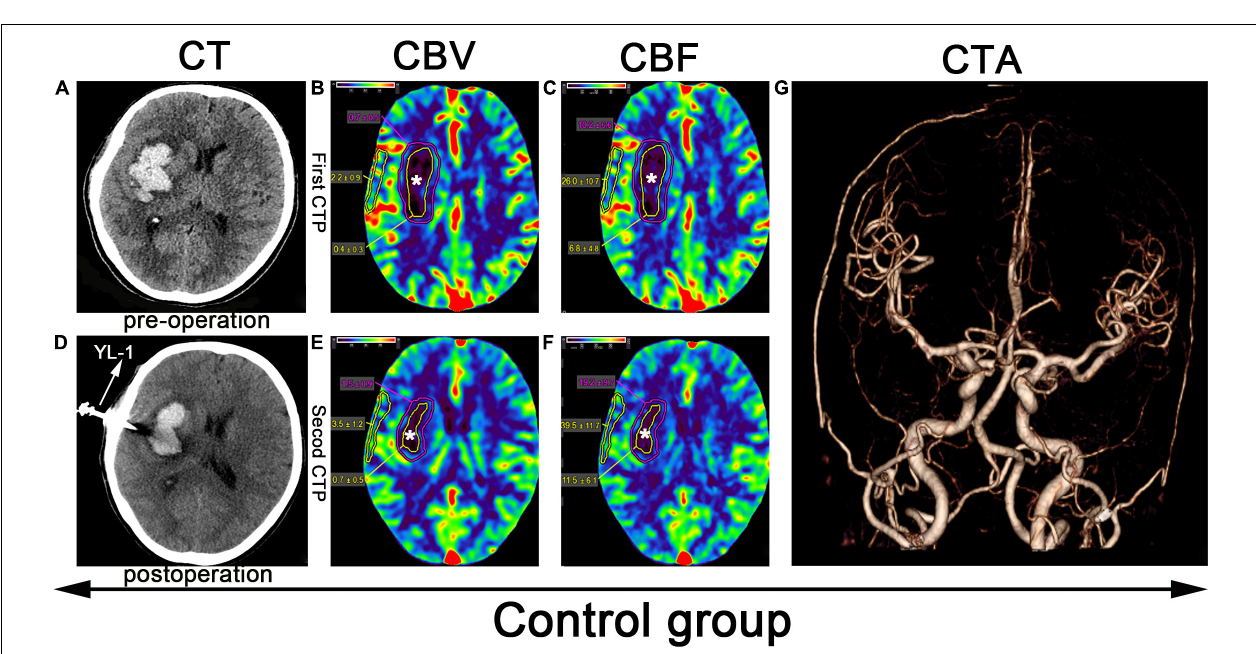
FIGURE 2 | CTP scan from a patient in the HBO group: (A) Preoperative left basal ganglia hemorrhage. (B,C,E,F) The yellow line denotes the hematoma area, the white star (*) denotes the hematoma center, the purple line denotes the hematoma margin, and the outer layer yellow line denotes the cortical area of the hematoma. (D) Application of a YL-1 puncture needle after puncture and drainage. (G) Normal CTA.